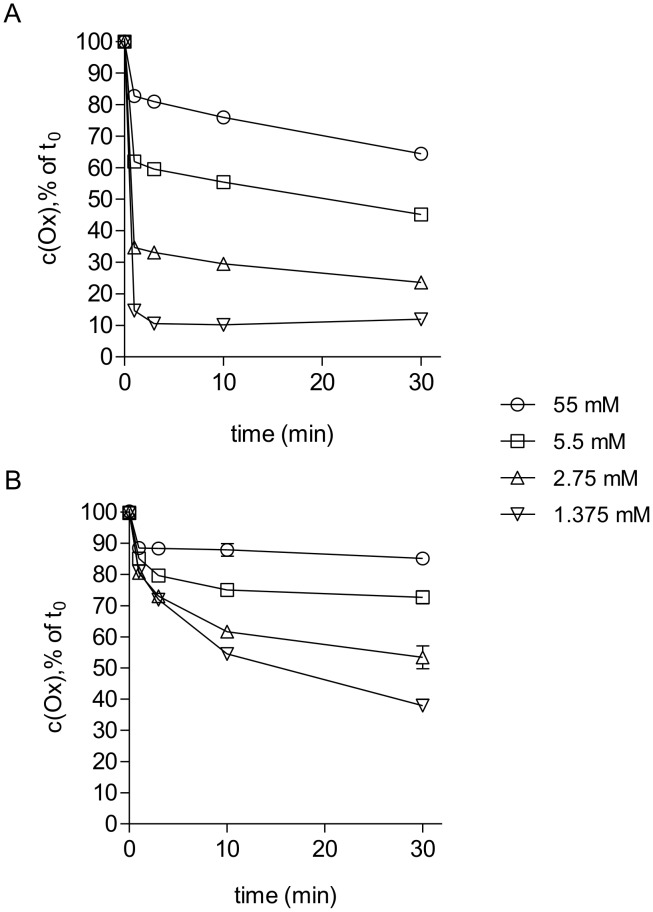
Decrease of oxidation capacity of NCT and NVC-422 in EHEC Direct Medium.Stock solutions of NCT (A) or NVC-422 (B) were 10-fold diluted in this medium to final concentrations of 55 mM, 5.5 mM, 2.75 mM and 1.375 mM. The oxidation capacity was measured with redox potentiometry after indicated time-points. Results with NVC-612 resembled those of NCT. Mean values ± SD from three independent experiments are shown.